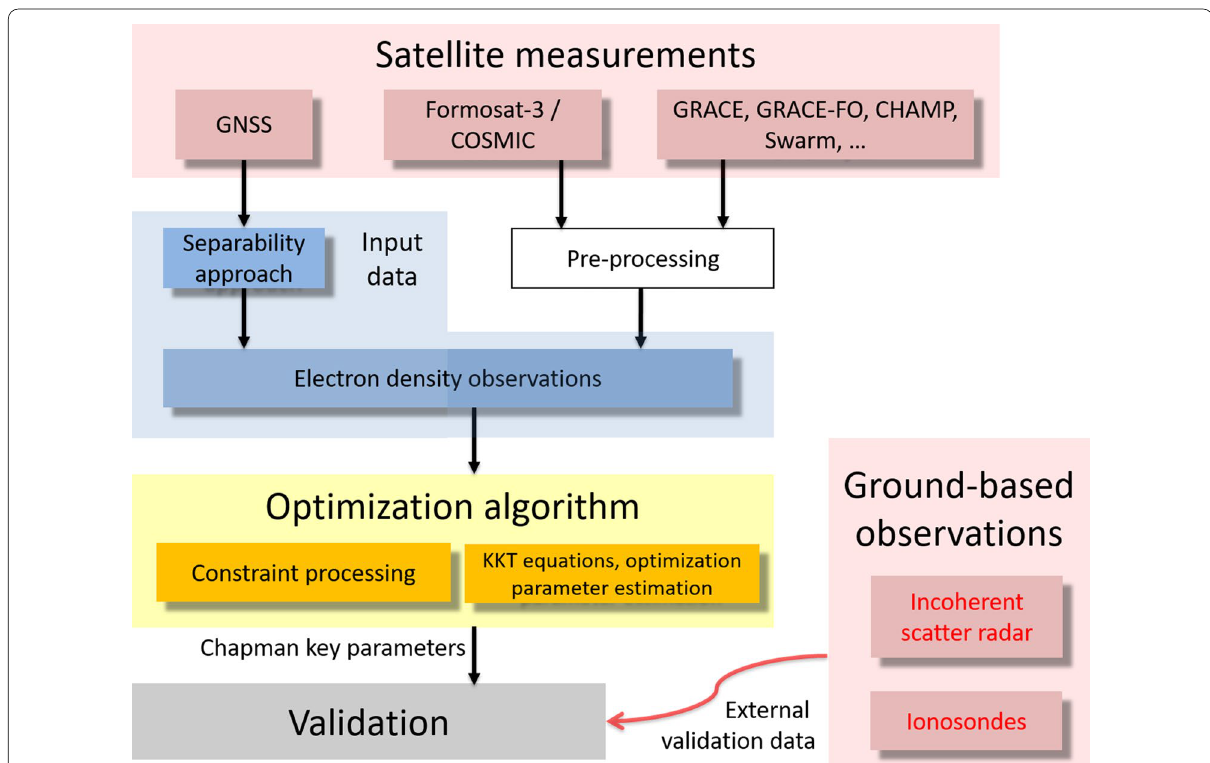
Fig. 8 Flowchart of the developed approach to estimate the electron density of the ionosphere and plasmasphere following the ICOA to estimate the selected Chapman key parameters κ r of the set K 1 by applying inequality and equality constraints